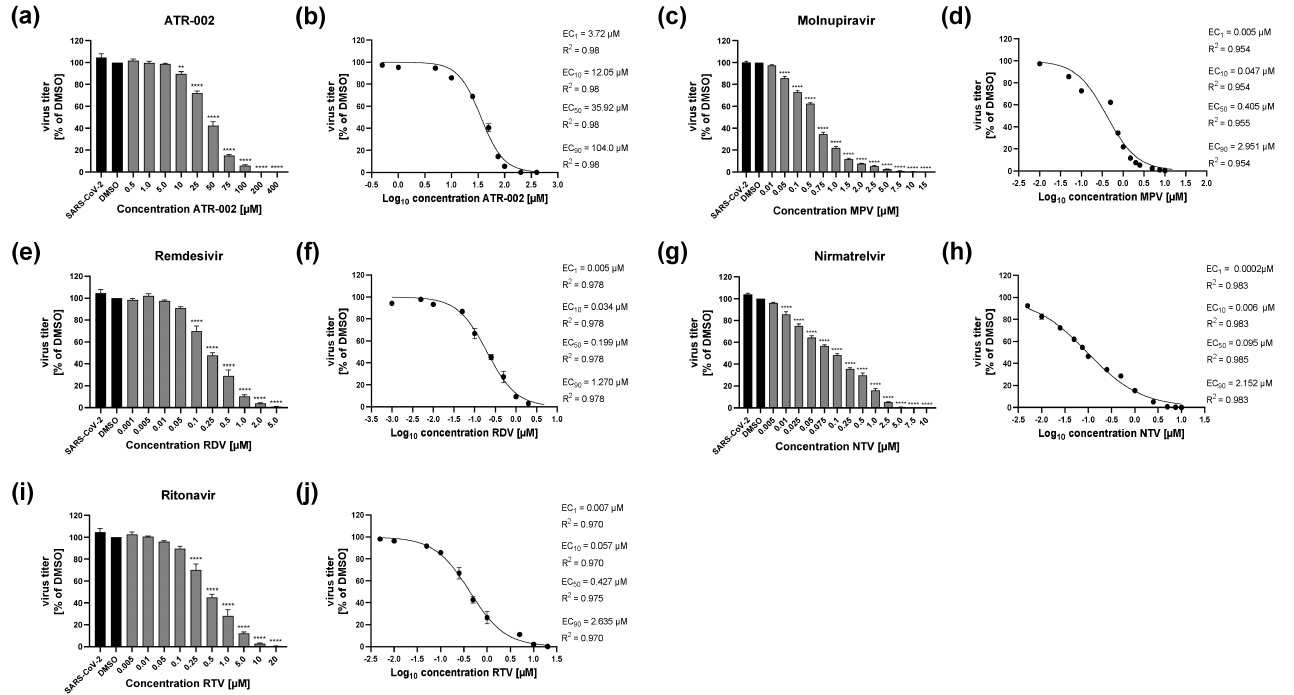
Figure 1. Inhibitory effect of ATR-002, MPV, RDV, NTV and RTV on SARS-CoV-2 replication. Calu-3 cells were infected with SARS-CoV-2 (D614G) (MOI: 0.01). One h.p.i. drug treatment was initiated. Untreated (SARS-CoV-2) and DMSO-treated cells served as negative controls. Viral titers were analyzed 48 h.p.i. ( a , c , e , g , i ). Viral titers in % of DMSO. DMSO was arbitrarily set to 100%. Shown are means ± SEM of five independent experiments, each performed in triplicates. Significance was calculated by one-way ANOVA in combination with a Dunnett’s multiple comparisons test using DMSO as reference (** p ≤ 0.0021; **** p ≤ 0.0001) (see also Figure S1). ( b , d , f , h , j ) Calculation of the EC